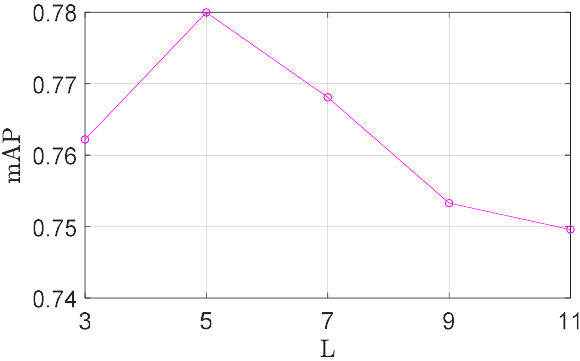
Figure 8. The e ff ect of L on the detection Figure 8. The effect of L on the detection accuracy.